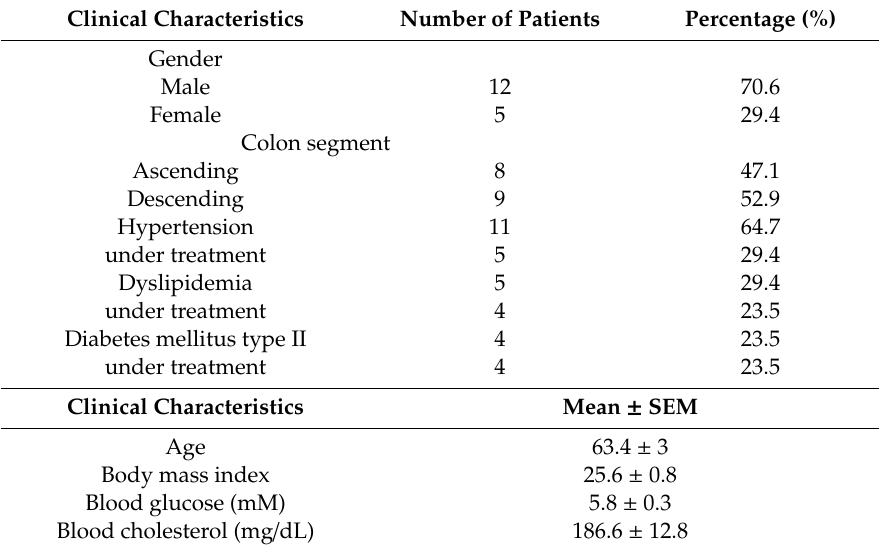
Table 1. Patient